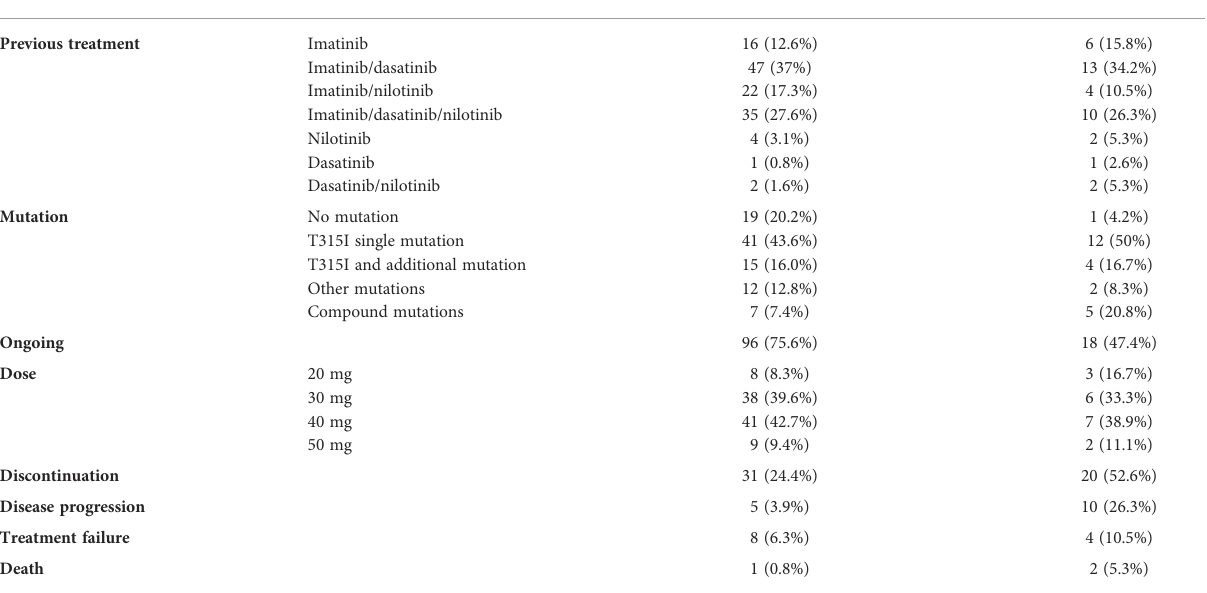
TABLE 2 Characteristics of patients in the olverembatinib trial